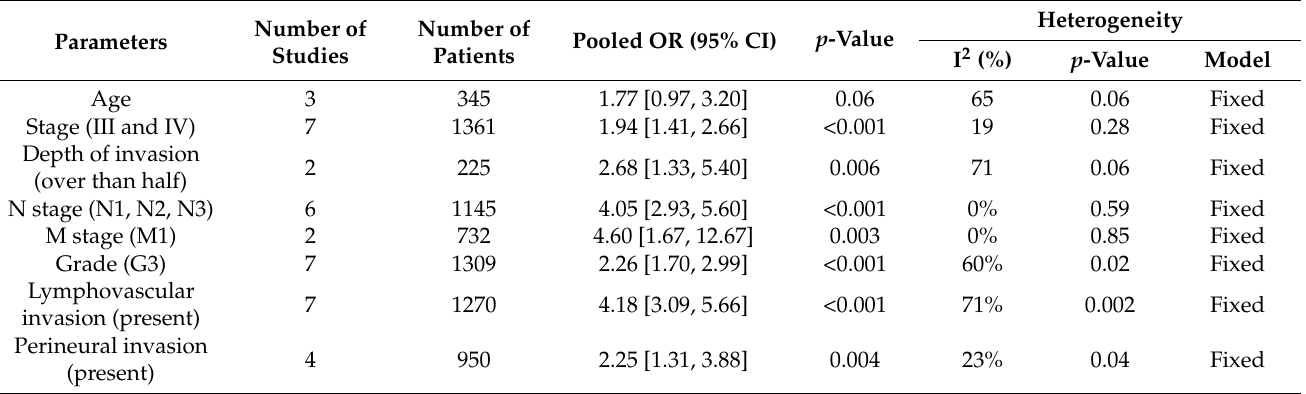
Table 2. Summary of a meta-analysis evaluating the relationship of tumor budding with clinicopatho- logical parameters of gynecological cancer.